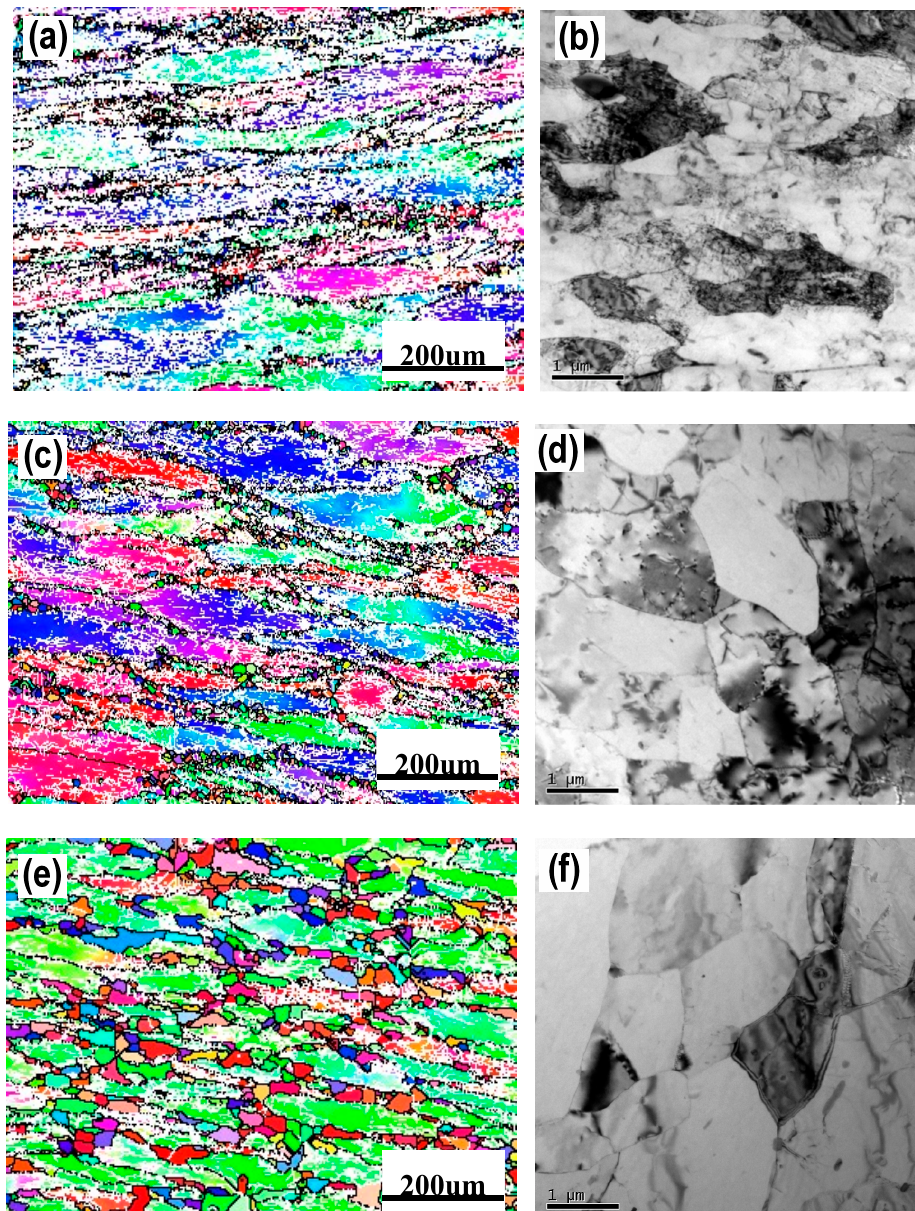
Figure 3. The microstructure of Al–4.8Mg alloy at various deformation conditions: ( a ), ( b ) T =280 °C, ε =1 s –1 ; ( c ), ( d ) T =400 °C,